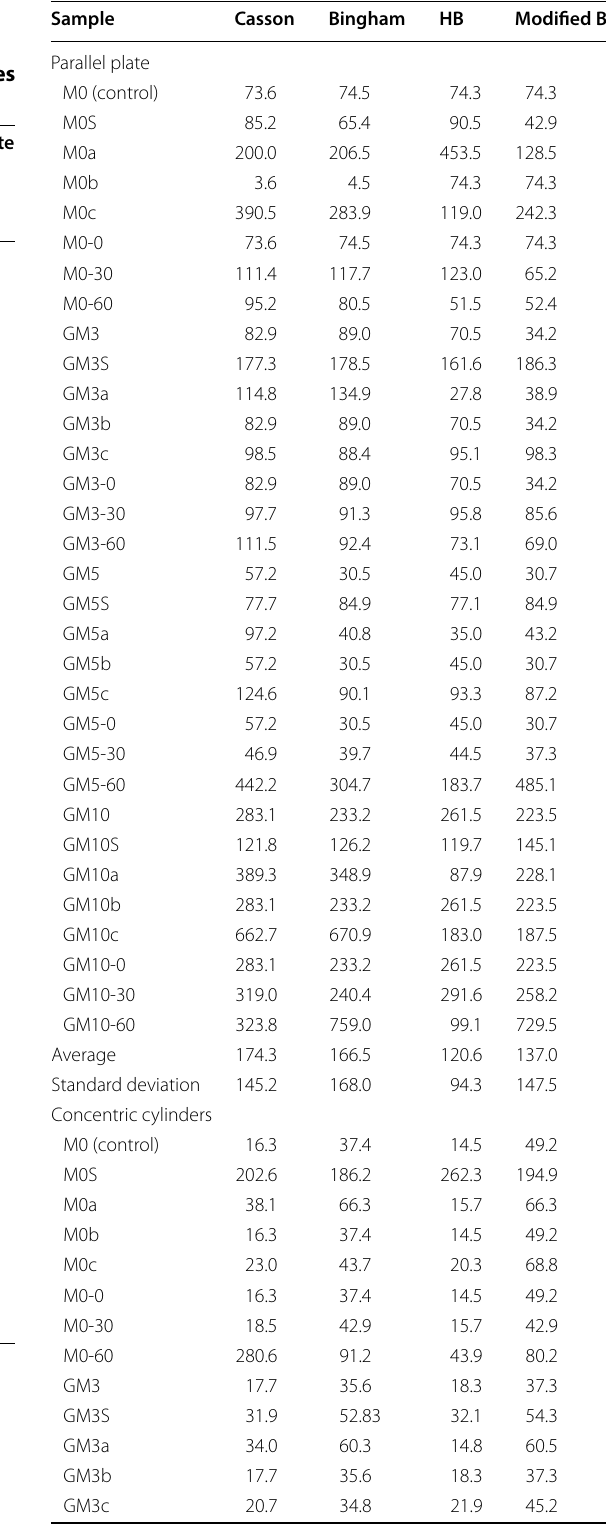
Table 16 Values of standard error for various rheological